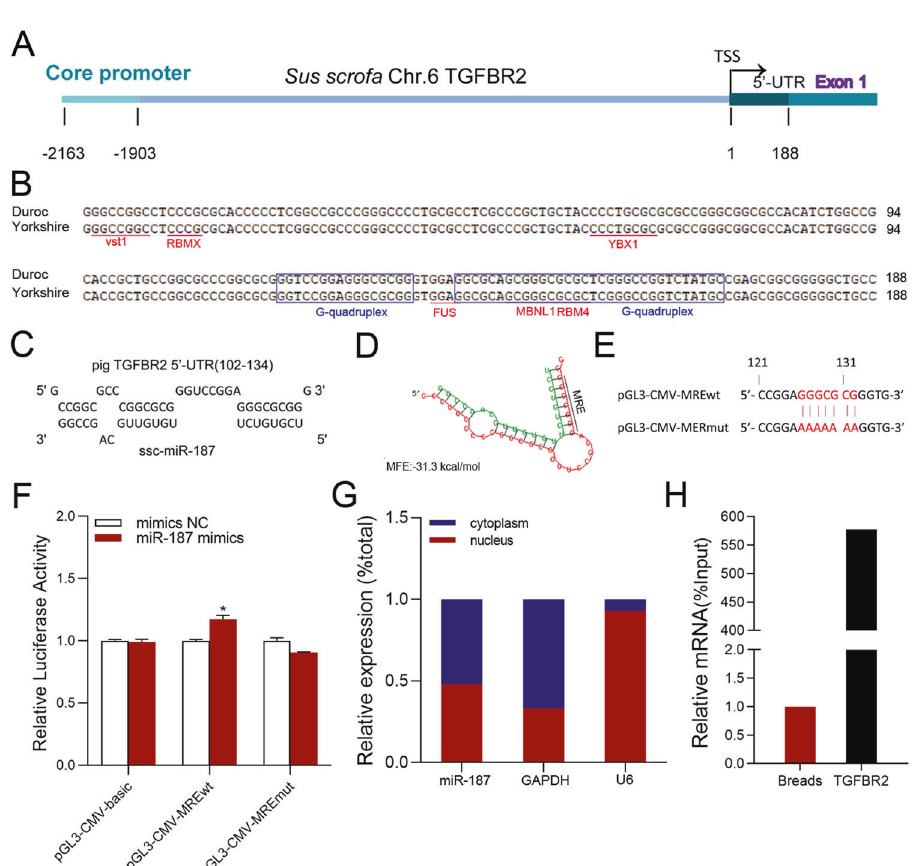
Fig. 1 miR-187 targets the 5 ′ -UTR of the sow TGFBR2 gene. A Schematic diagram of TGFBR2 5 ′ regulatory region. B Sequence alignment of TGFBR2 5 ′ -UTR from Duroc and Yorkshire pigs. RBP-binding elements are indicated by underlining. RNA G-quadruplexes are indicated by blue boxes. C The MRE motif of miR-187 in TGFBR2 5 ′ -UTR. D Prediction of minimum free energy (MFE) of binding miR-187 and TGFBR2 5 ’ -UTR using RNAhybrid. E Schematic showing the reporter vectors of TGFBR2 5 ’ -UTR containing wild-type and mutated MRE of miR-187. F